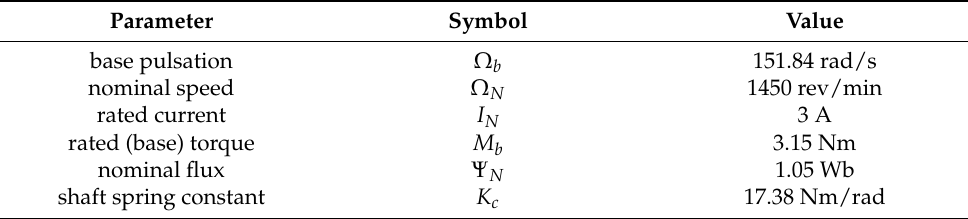
Table A1. Parameters of